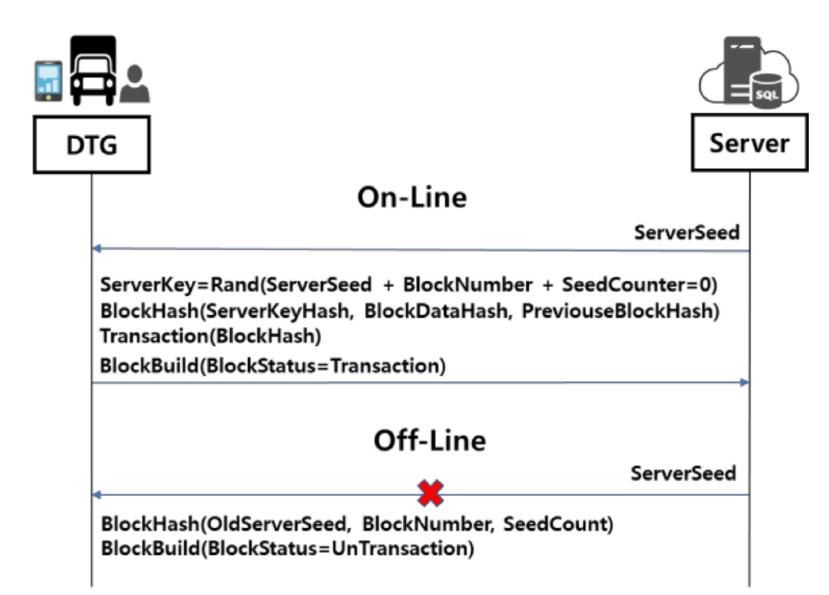
Figure 3. Block generation of